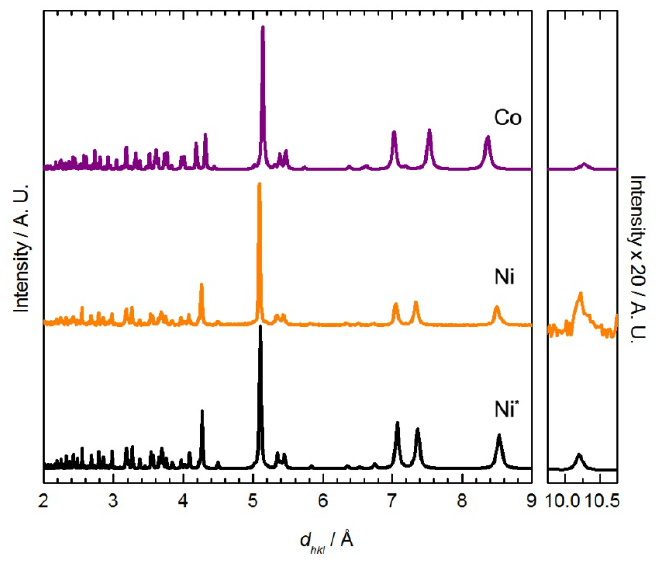
Figure 5. Comparison between the powder X-ray diffractogram (generated from single-crystal data) for Co[Au(CN) diffractogram for Ni[Au(CN) the proposed structural model (Ni*, black).